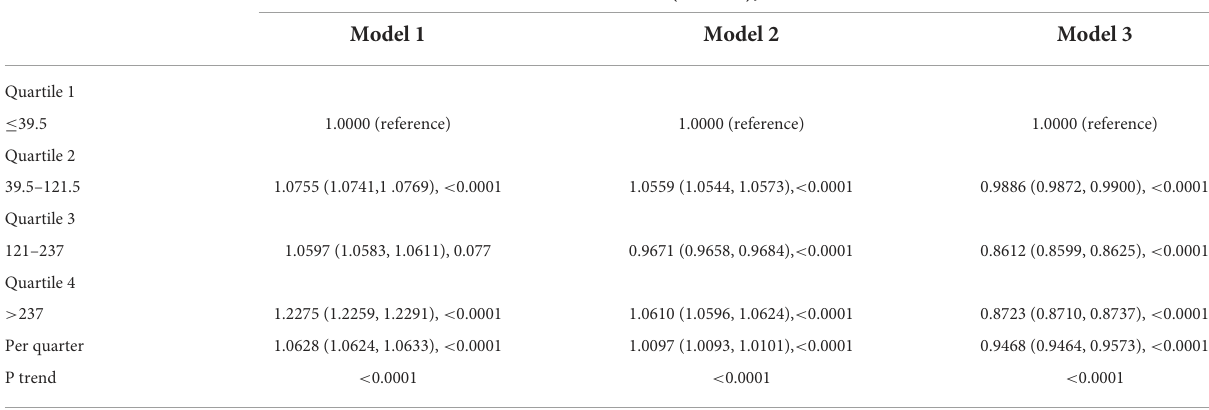
TABLE 2 Association between caffeine intake and kidney